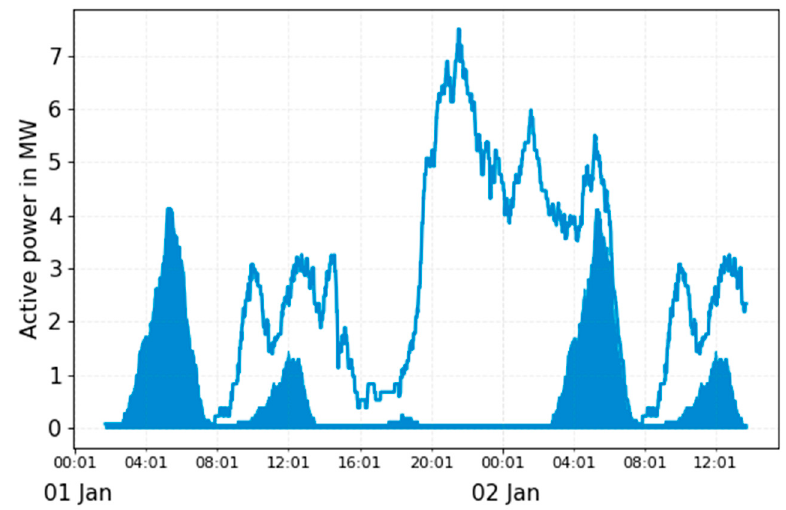
Figure 8. Load profile resulting from the original charging schedule together with the preconditioning